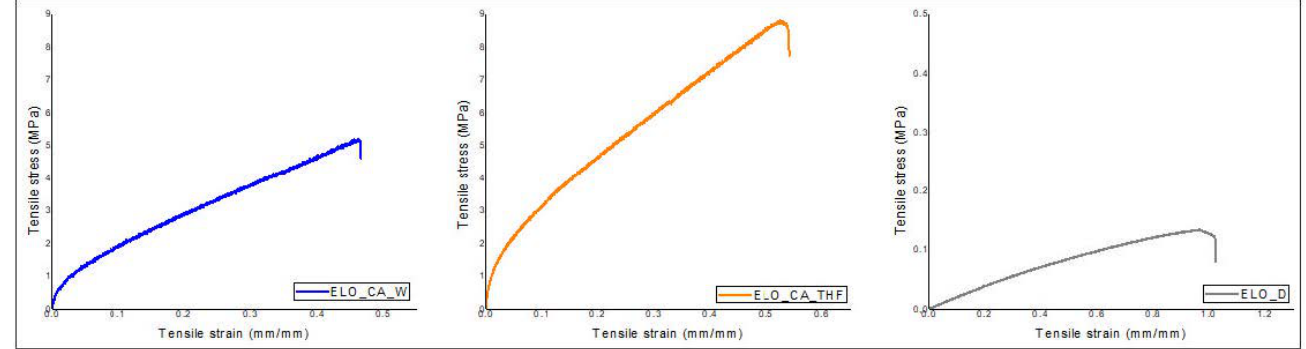
Figure 9. Graphical representation of stress–strain curves for ELO-based polymeric materials.